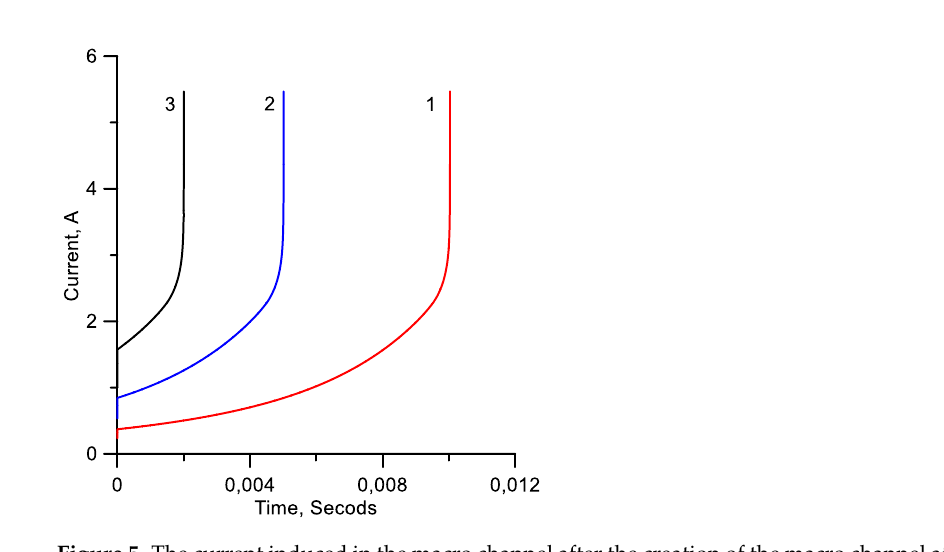
Figure 5. The current induced in the macro channel after the creation of the macro channel at different heights. The speed of propagation of the macro was assumed to be 10 6 m/s. (1) 10 km; (2) 5 km; (3) 2 km. For clarity, the time delays involved in the initiation of current at different levels were removed.